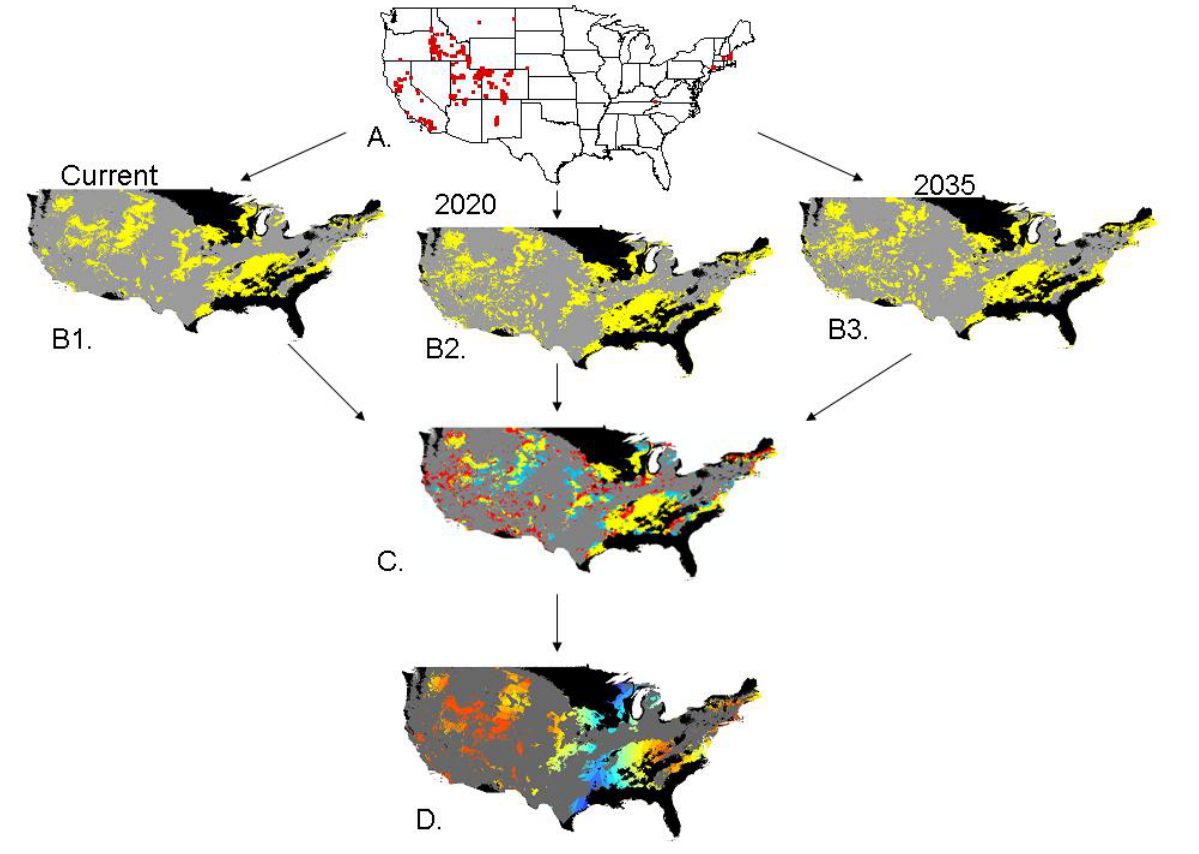
Figure 2. Potential habitat suitability modeling process for Lepidium latifolium. (A) Distribution of data points. (B1) Current potential habitat suitability, (B2) Potential habitat suitability in 2020, (B3) Potential habitat suitability in 2035. (C) Scenario model showing stable potential suitable habitat in yellow, decreasing potential habitat suitability in blue, and increasing potential habitat suitability in red. (D) Invasion index with colors on the red end of the spectrum closer to potential seed source and colors on the blue end of the spectrum farther away. In the entire figure grey represents unsuitable habitat and black represents clamping, or areas the model was extended beyond the environmental space it was trained